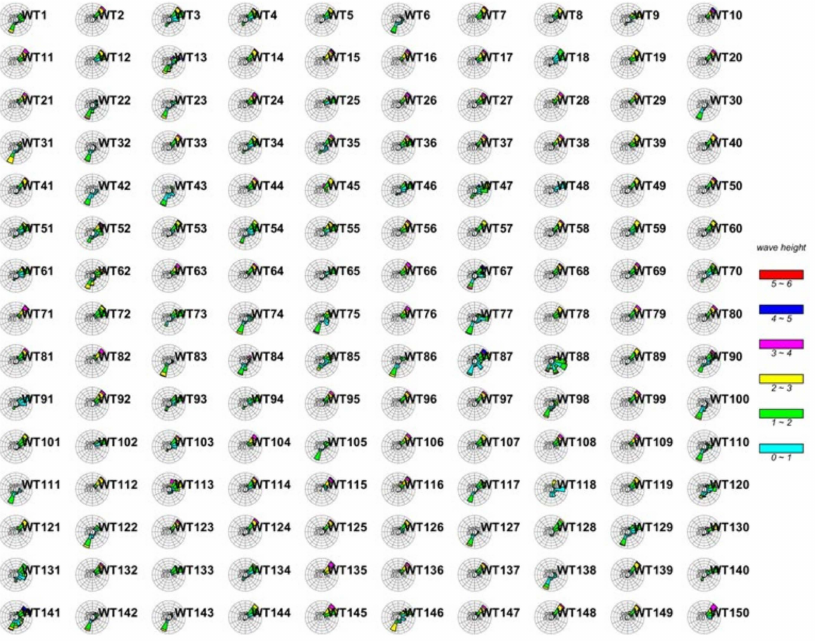
Figure 6. Distribution of the significant wave height and the mean wave direction associated with each weather type at THL2B